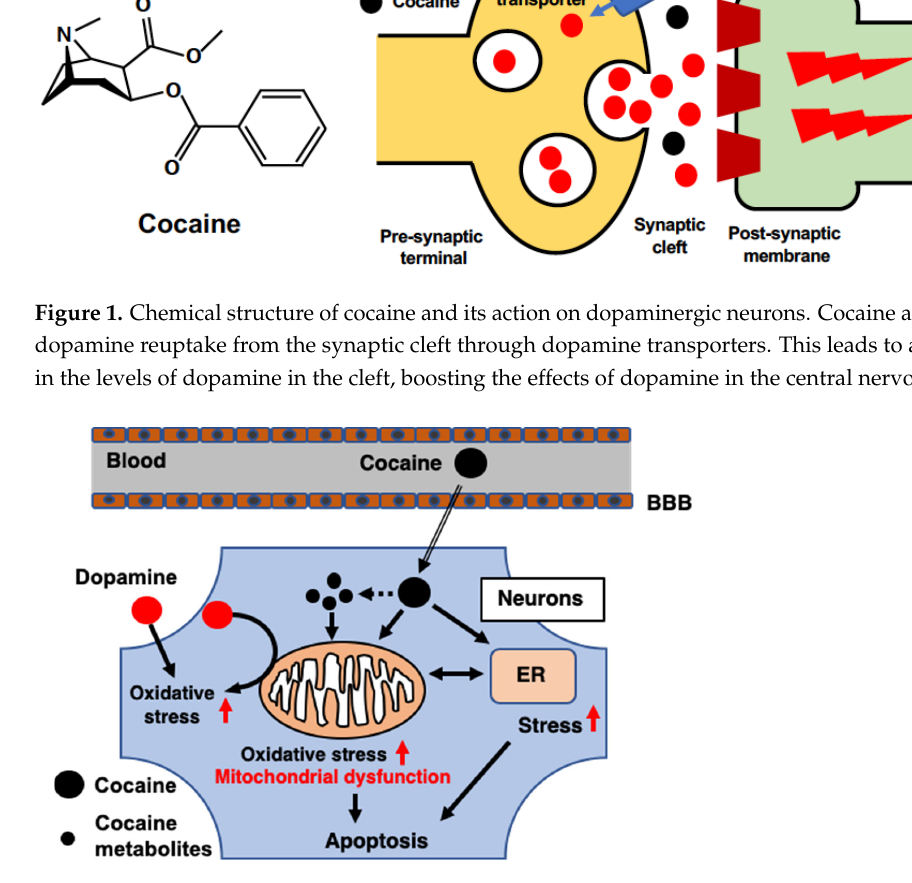
Figure 2. Effects of cocaine on neuronal cells. Cocaine enters the central nervous system by crossing and/or disrupting the blood–brain barrier (BBB). After entering neuronal cells, cocaine and its me ‐ tabolites induce subcellular stress within mitochondria and the endoplasmic reticulum (ER). The aggregation of dopamine induced by cocaine also results in oxidative stress during the degradation of dopamine. Overwhelmed stress and direct damage from cocaine lead to mitochondrial dysfunc ‐ tion which results in cell